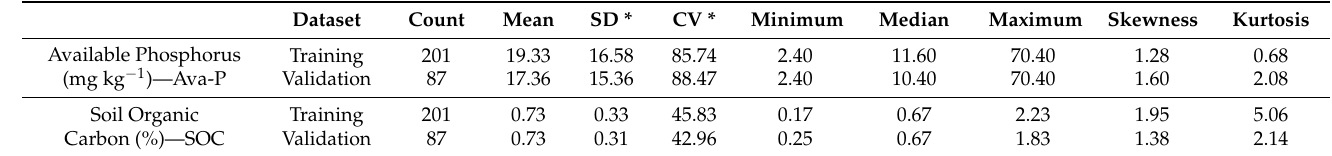
Table 3. Descriptive statistics of soil properties in the soil data